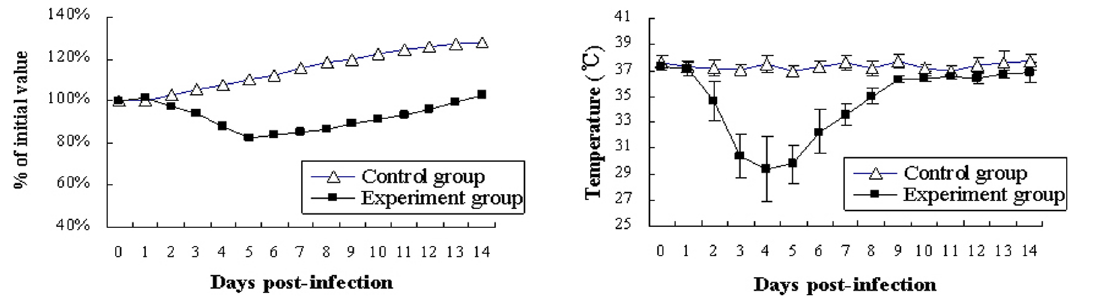
Figure 4. Body weight and temperature of mice after H9N2 viral infection. Mice were inoculated i.n. with 10 6 EID 50 of Ck/HB/4/08 H9N2 viruses. Body weight ( A ) and temperature ( B ) were monitored daily for a 14-day observation period. Body weight was expressed as a percentage of the initial value. Data represent the mean of at least three mice of each group.